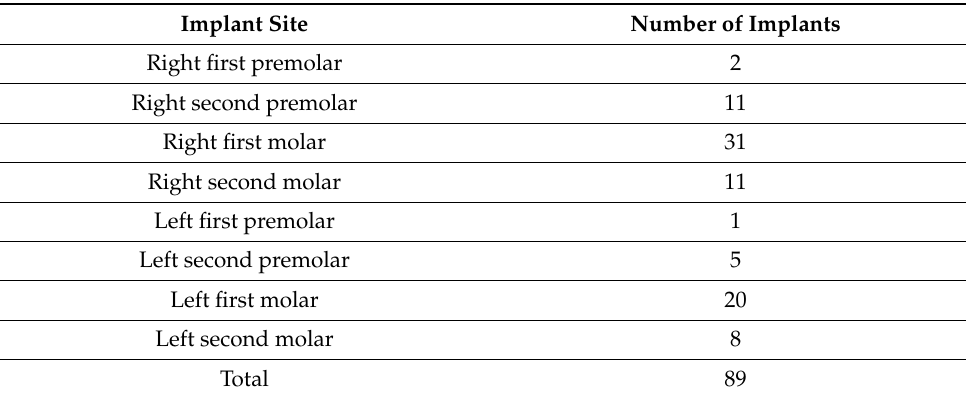
Table 3. Implant distribution per location in the maxilla.